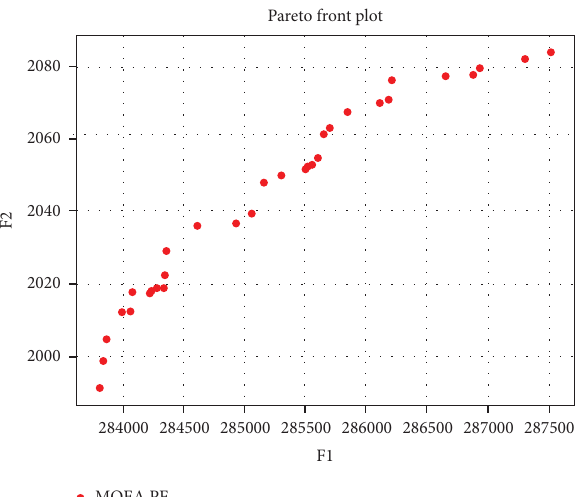
Figure 6: Objective values of Pareto optimal solutions generated by the designed algorithm.